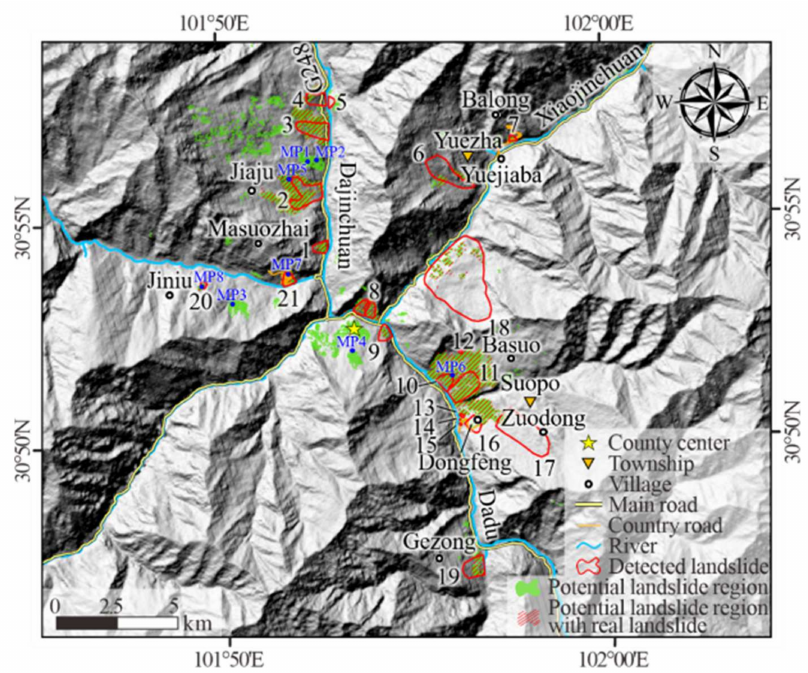
Figure 9. Locations of the real landslides identified through field surveys in the study area. Table 3. General information of the real landslides detected from field surveys. Landslide